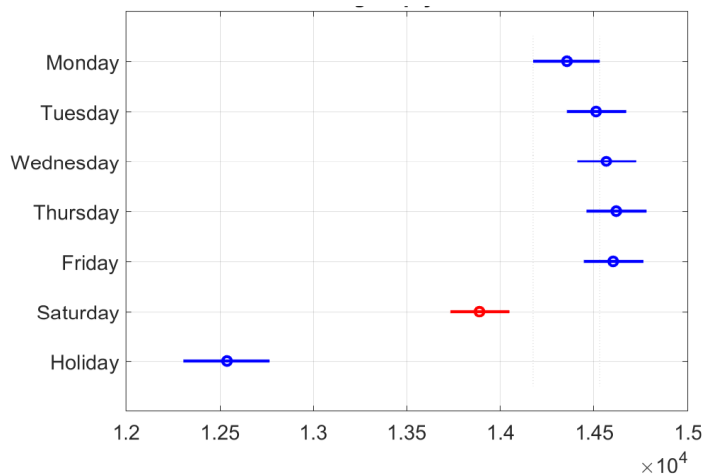
Figure 10. Multicomparison of the daily means of the energy demand for each type of day.